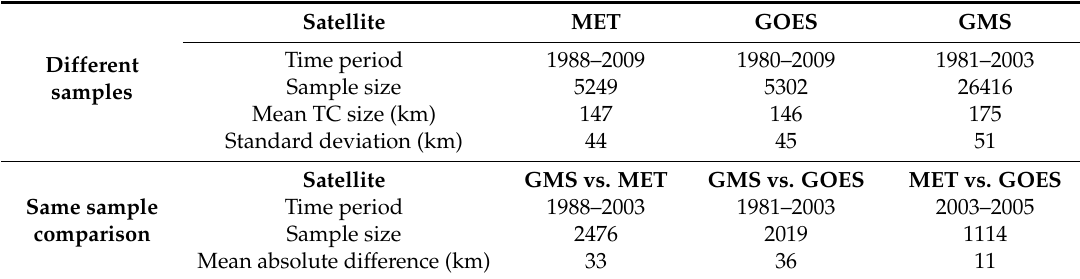
Table 2. Satellite data used for comparative analyses.